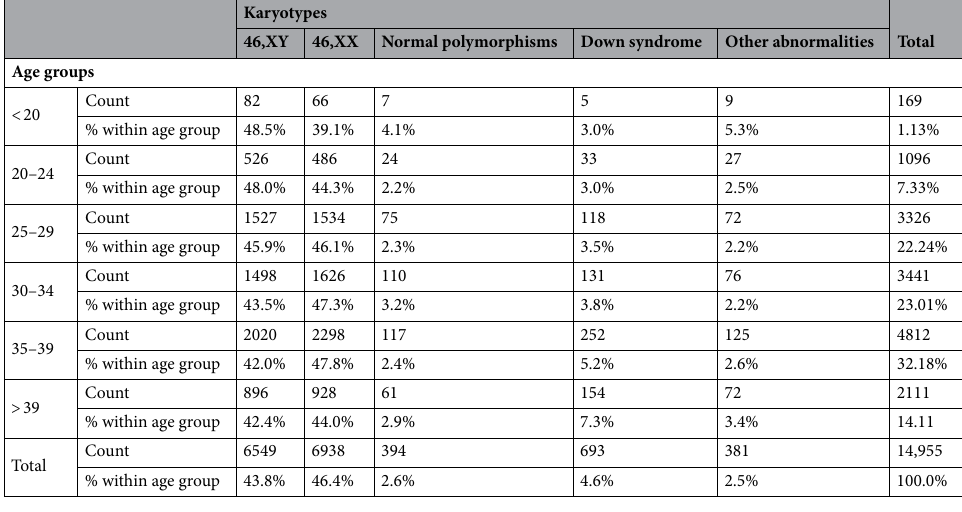
Table 5. Association between maternal age and presence of chromosomal abnormalities.